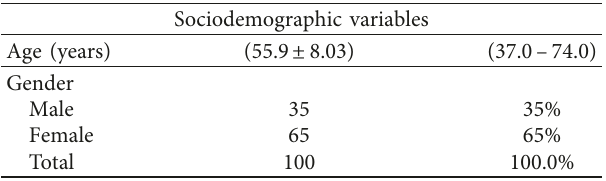
Table 1: The distribution of patients according to sociodemo- graphic characteristics.